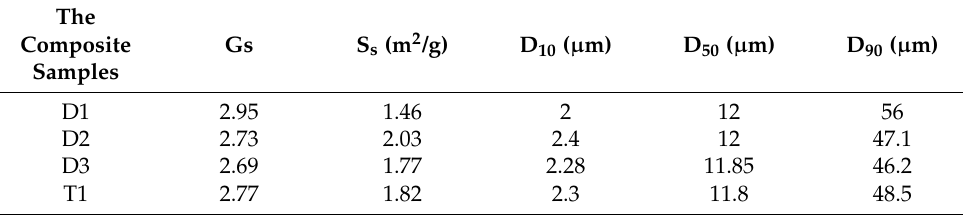
Table 2. Physical properties of composite samples.